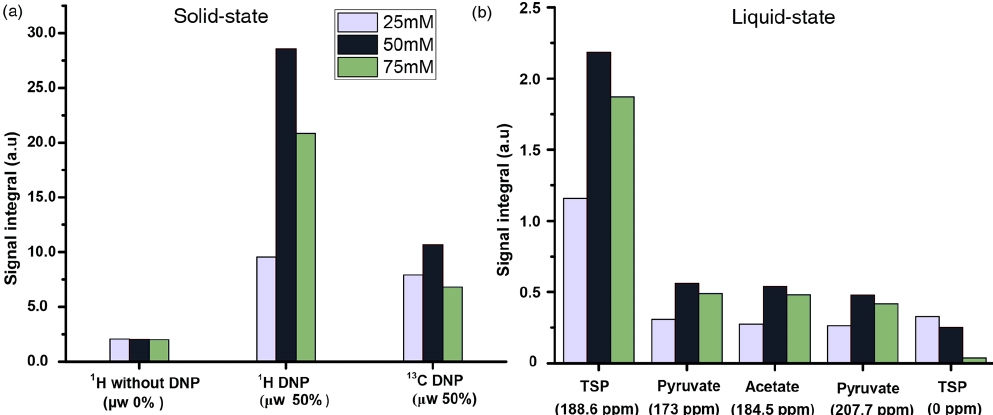
Figure 3. Comparison of signal integral values of (a) 1 H and 13 C signals in the solid state and (b) 13 C– { 1 H } liquid-state signal integrals of metabolites with a 25, 50, and 75mM TEMPOL